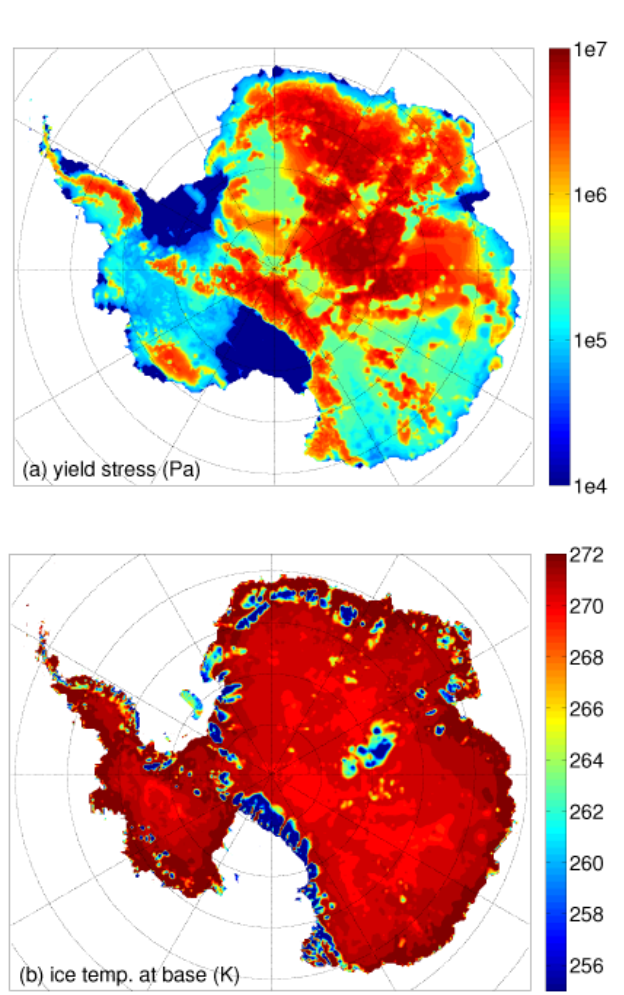
Fig. 3. (a) Map of yield stress τ c , following Eqs. (9–12). (b) Tem- perature at the base of grounded